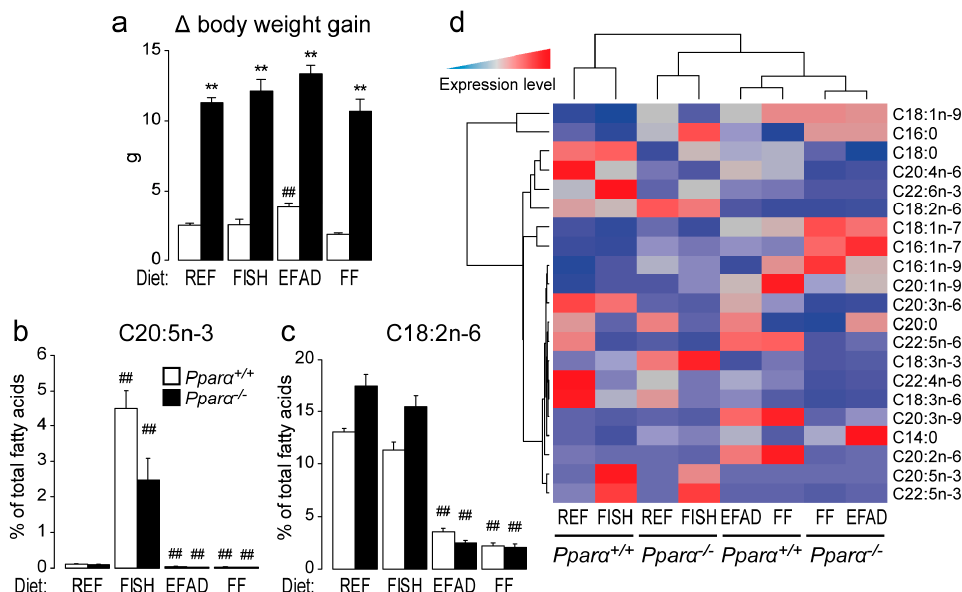
Figure 1. Effect of dietary fat on hepatic lipid composition. Wild-type ( Ppar α +/+ ) and total Ppar α knockout ( Ppar α − / − ) mice fed a standard diet (REF), a diet enriched in n-3 essential fatty acids from fish oil (FISH), an essential fatty acid-deficient (EFAD) diet, or a fat-free (FF) diet ad libitum for 10 weeks were euthanized at ZT14 in the fed state. ( a ) Determination of the delta body weight gain; ( b , c ) quantification of hepatic C20:5n-3 eicosapentaenoic acid ( b ); C18:2n-6 linoleic acid ( c ); and ( d ) hierarchical clustering of major hepatic fatty acids quantified by gas chromatography. n = 6–8 mice/genotype/diet. Data represent mean ± SEM. * significant genotype effect, # significant effect of diet composition. ** or ## p ≤ 0.001. REF: standard diet; FISH: diet enriched in n-3 essential fatty acids from fish oil; EFAD: essential fatty acid-deficient diet; FF: fat-free diet.